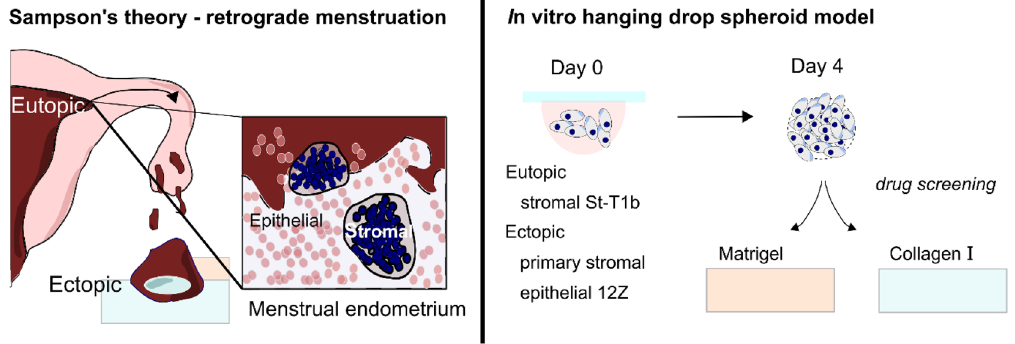
Figure 1. Endometriosis modelling in vitro. Left. Sampson’s theory of retrograde menstruation. Menstrual tissue contains stromal condensates (dark blue) and collapsed epithelial glands (pink). Ectopic lesions are frequently described to have a ‘bullet-like appearance’ Right. Spheroids generated using the hanging drop method as a model of collapsed endometrium architecture are placed on either Matrigel or collagen I on day 4 and their phenotype on the hydrogels and the effect of pharmacological intervention is